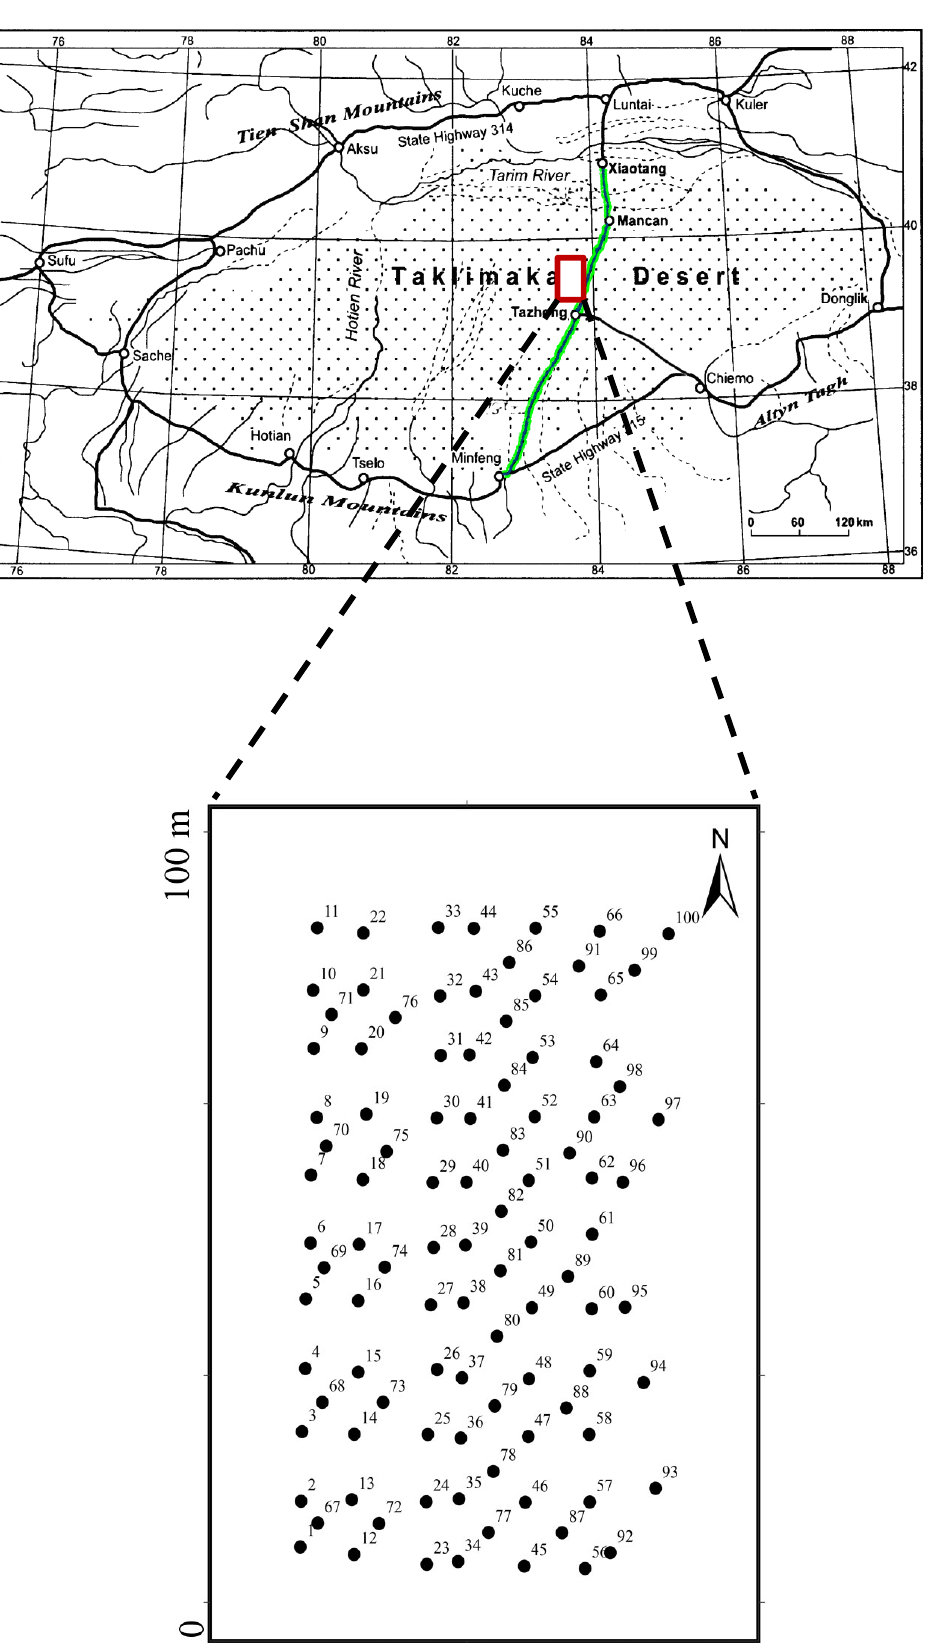
Figure 1. Locations of sampling sites at the study area. The green line shows the Taklimakan Desert Highway Shelterbelt. The red box shows the sampling